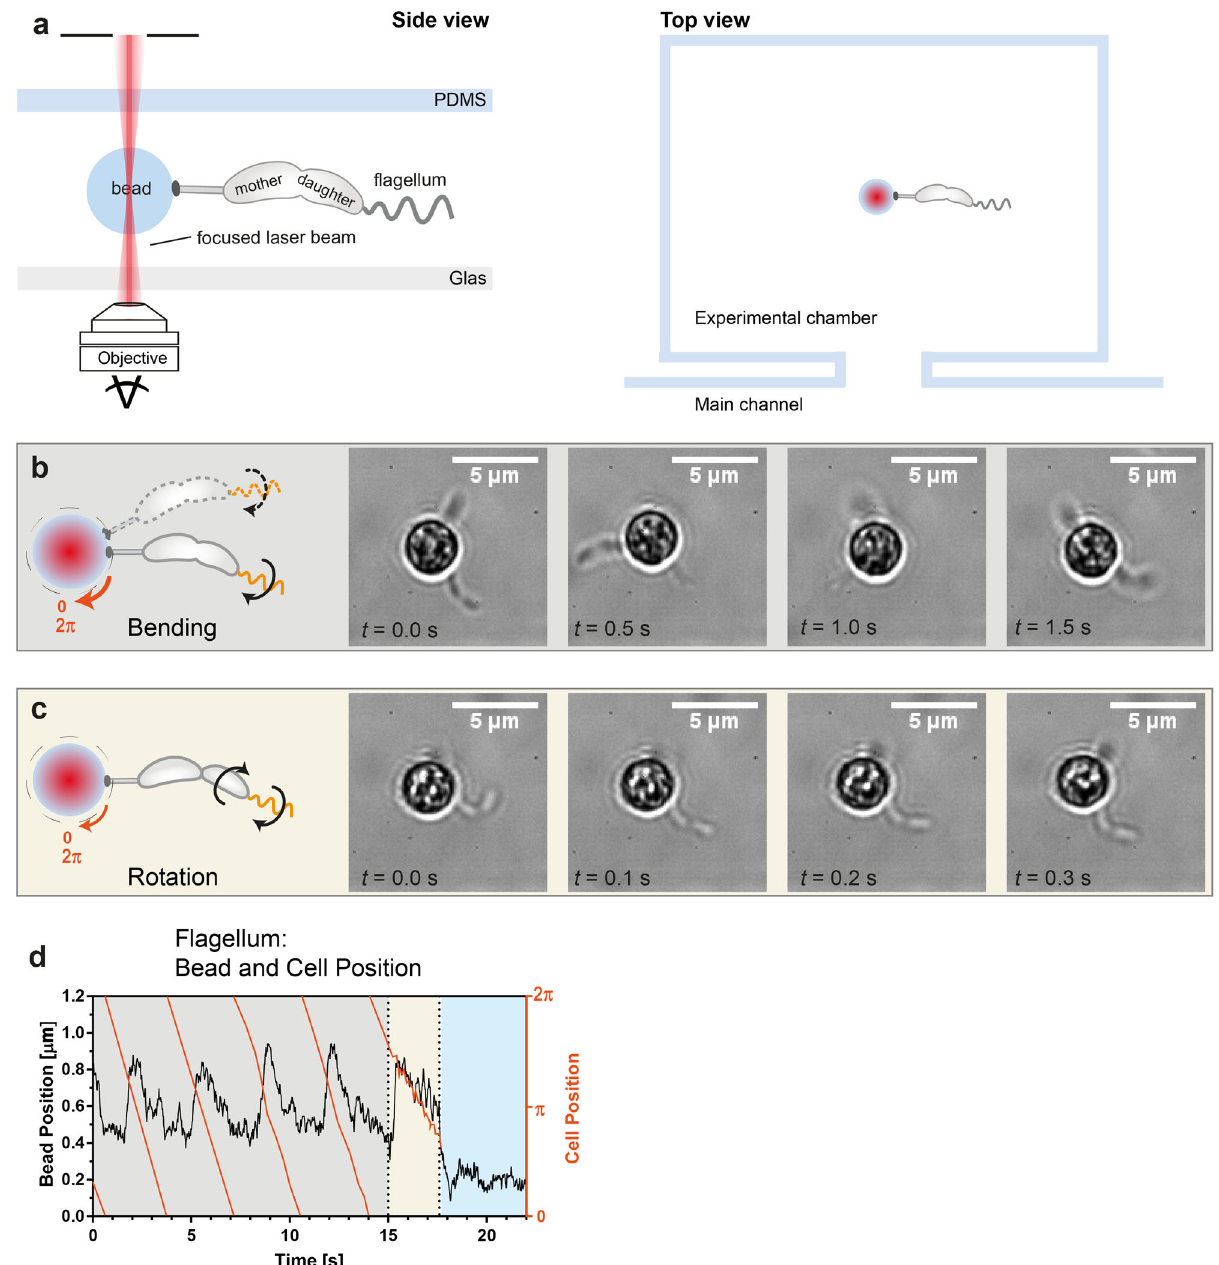
Fig. 2 Predivisional cells attached to a bead in optical tweezers. a Scheme of the experimental set-up (side and top view). The predivisional cells are attached to a polystyrene bead, placed in a micro fl uidic chamber and hold by optical tweezers. b , c Scheme and bright fi eld images of two WT cells attached to a bead with a diameter of 3 µ m in the optical tweezers. b The mother and the daughter sides of the predivisional cell are still fi rmly connected; the rotation of the fl agellum induces a gyrational motion of the bead and the cell around the center of the optical tweezers. c The connection between the two sides of the predivisional cell is softened, the rotation of the fl agellum causes a rotation of the daughter side around its long axis. The gyration of the predivisional cell proceeds albeit slower. d Position of the bead (black) and the cell (orange) during gyration of the cell (gray background), rotation of the cell around the long axis (yellow background), and when cell separation is completed (blue